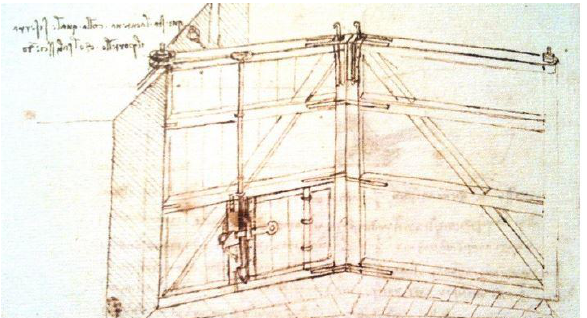
Figure 4 . Leonardo da Vinci’s design, used for navigation and visible in the Codex